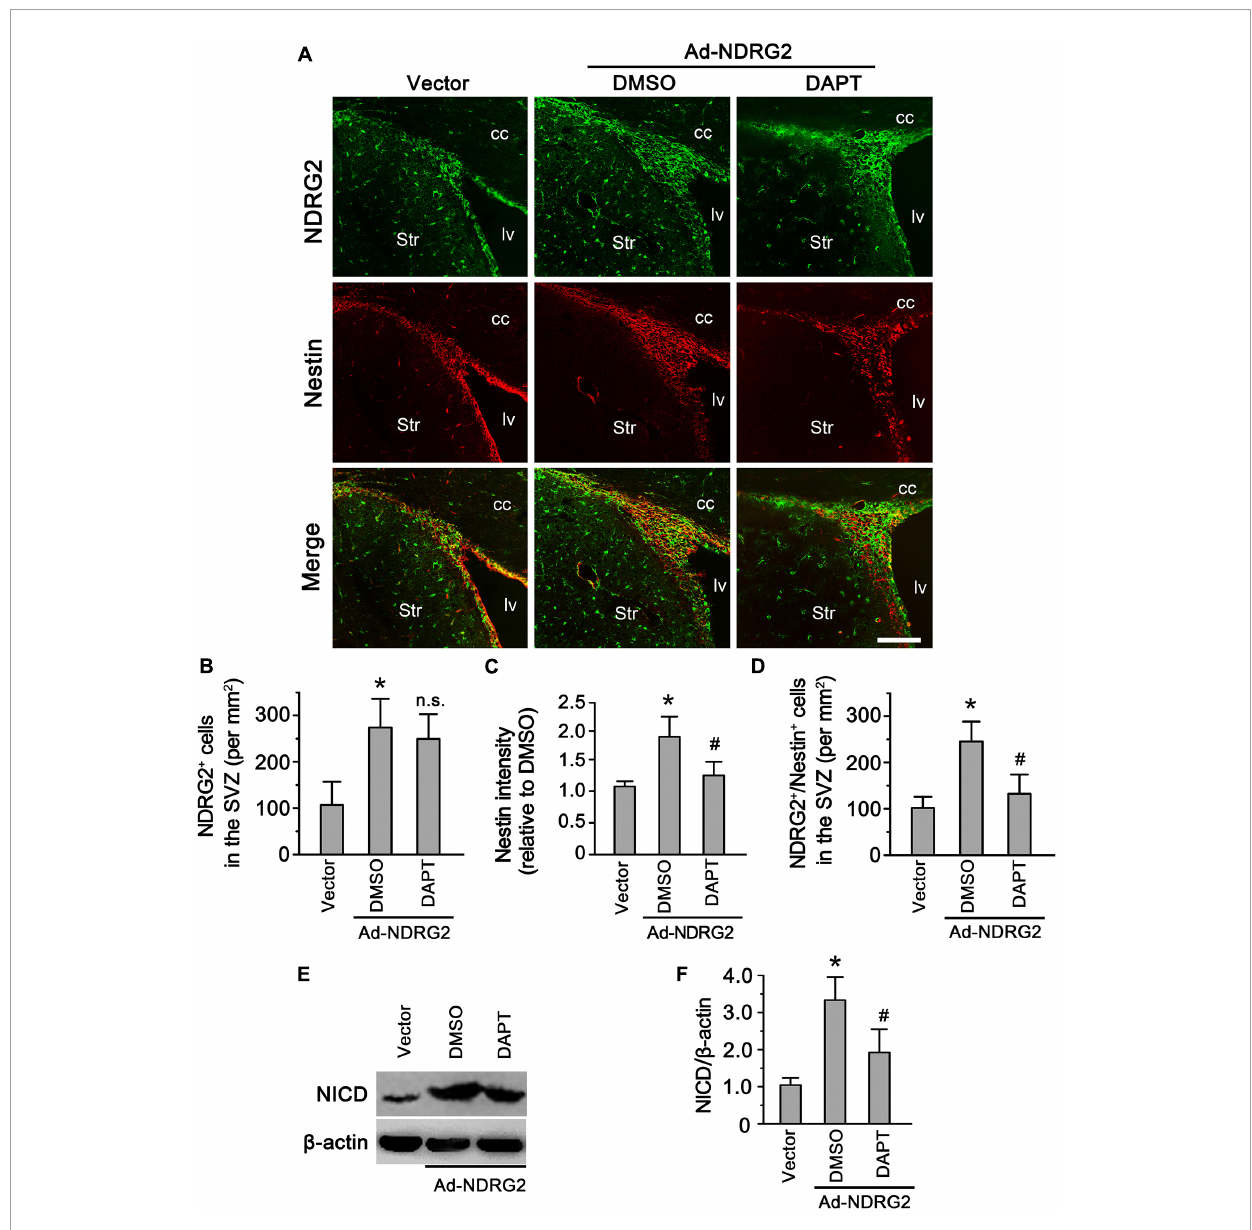
FIGURE5 NDRG2 regulates endogenous NSCs in the SVZ via Notch signal. At the time when NDRG2-overexpressing adenoviruses were injected into the lateral ventricle, DAPT was administrated intracerebroventricularly into the contralateral ventricle. At 7 day following injection, double immunostaining of Nestin and NDRG2 was performed. (A–D) Compared with the blank vector control, NDRG2 overexpression significantly increased the immunoreactive signals of Nestin (C) and the number of Nestin + /NDRG2 + cells (D) in the SVZ. DAPT was able to mitigate these effects induced by NDRG2 overexpression compared with the DMSO control (C,D) but did not affect the number of NDRG2 + cells (n.s., no significance), (B) . cc, corpus callosum; lv, lateral ventricle; Str, striatum. Scale bar in panel (A) : 50 µ m. (E,F) Under the normal condition, low levels of NICD were observed in the SVZ. Adenovirus-mediated NDRG2 overexpression significantly increased NICD expression of the SVZ and, however, DAPT attenuated NDRG2-induced NICD expression. Data are normalized to the DMSO control and shown as mean ± SEM ( n = 5). * p < 0.05, vs. the blank vector control. # p < 0.05, vs. the DMSO